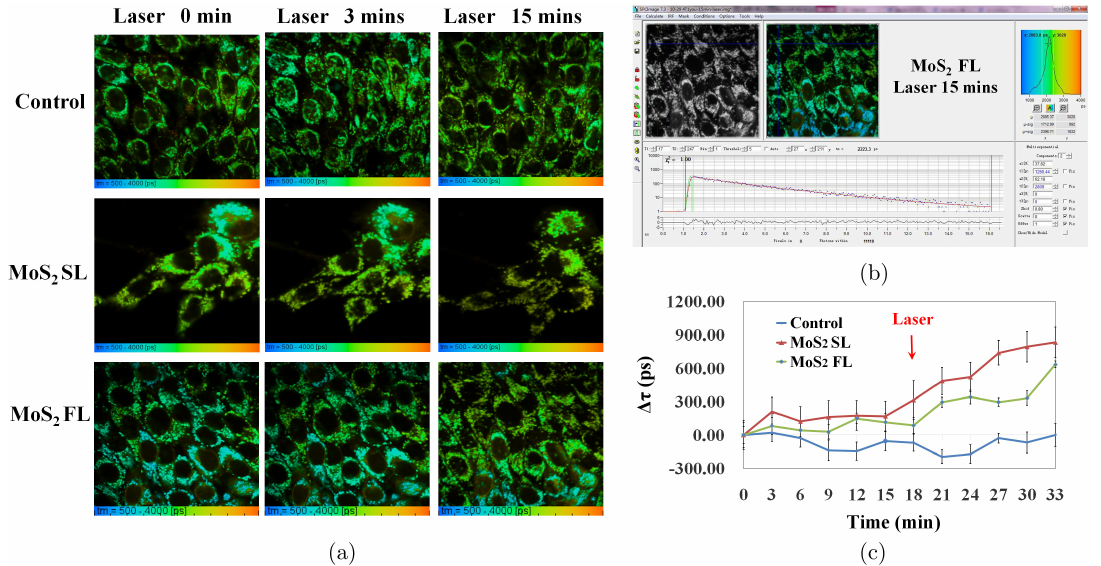
Fig. 4. (a) The °uorescence lifetime images of the 4T1 cells treated with PBS (as control), MoS 2 SL or MoS 2 FL nanosheets under NIR laser irradiation at 0 min, 3 mins or 15 mins (808 nm, 1 W/cm 2 ). (b) One representative raw data from the cells treated with MoS 2 FL nanosheets under NIR laser irradiation at 15 mins. The insets in the upper-left region are the °uorescence intensity and the °uorescence lifetime images, respectively. The inset in the upper-right corner shows the histogram of lifetime distribution of the °uorescent dye. The inset in the lower part represents the decay curve, in which the x axis means the counting time while the y axis shows the counted photon number. (c) Changes of the °uorescence lifetimes of R123 dyes in the cells treated with PBS (as